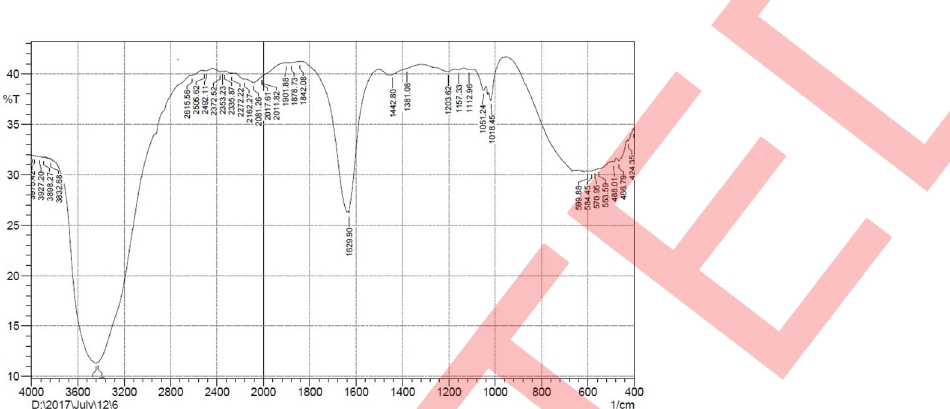
Fig 4. FT-IR spectrum of glycolipid biosurfactant by Streptomyces puniceus strain RHPR9.